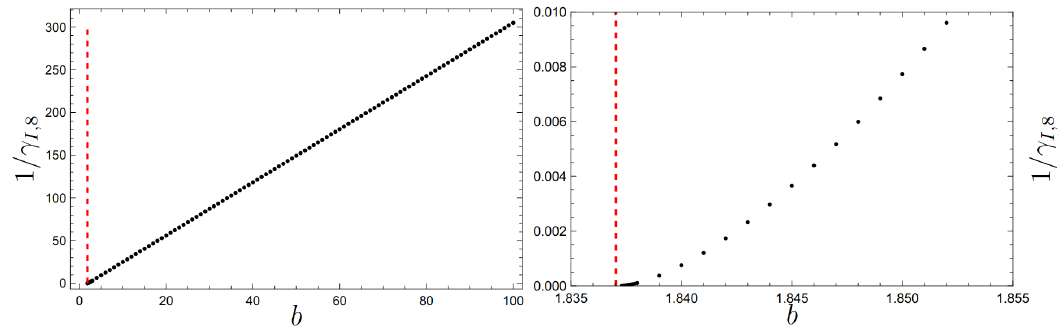
Figure 3 . Thermal conformal order parameter γ 8 ≡ T − 8 hO 8 i of the deformed Model I diverges as b → b crit ,I + 0 > 1 , represented by the dashed vertical red